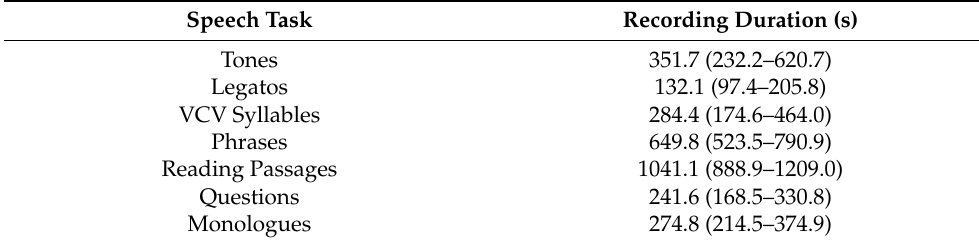
Table 1. Recording duration by speech task, shown as mean